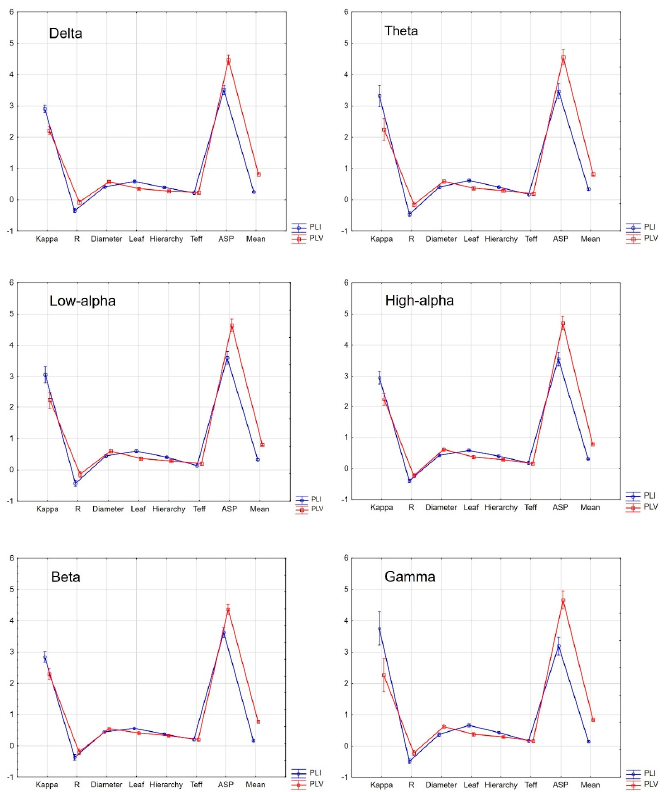
Figure 2. Within-group comparisons of MST indicators (kappa, R, diameter, leaf, hierarchy, Teff, ASP, and mean) based on PLI (blue curve) and PLV (red curve) FC strength indicators in the SCH group. The vertical bars represent 0.95 confidence intervals. Comparisons were selectively computed for individual frequencies.